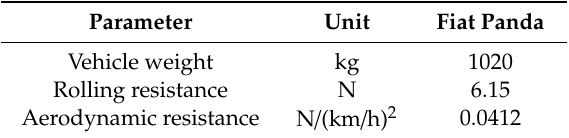
Table 4. Vehicle parameters implemented in the “test generator”